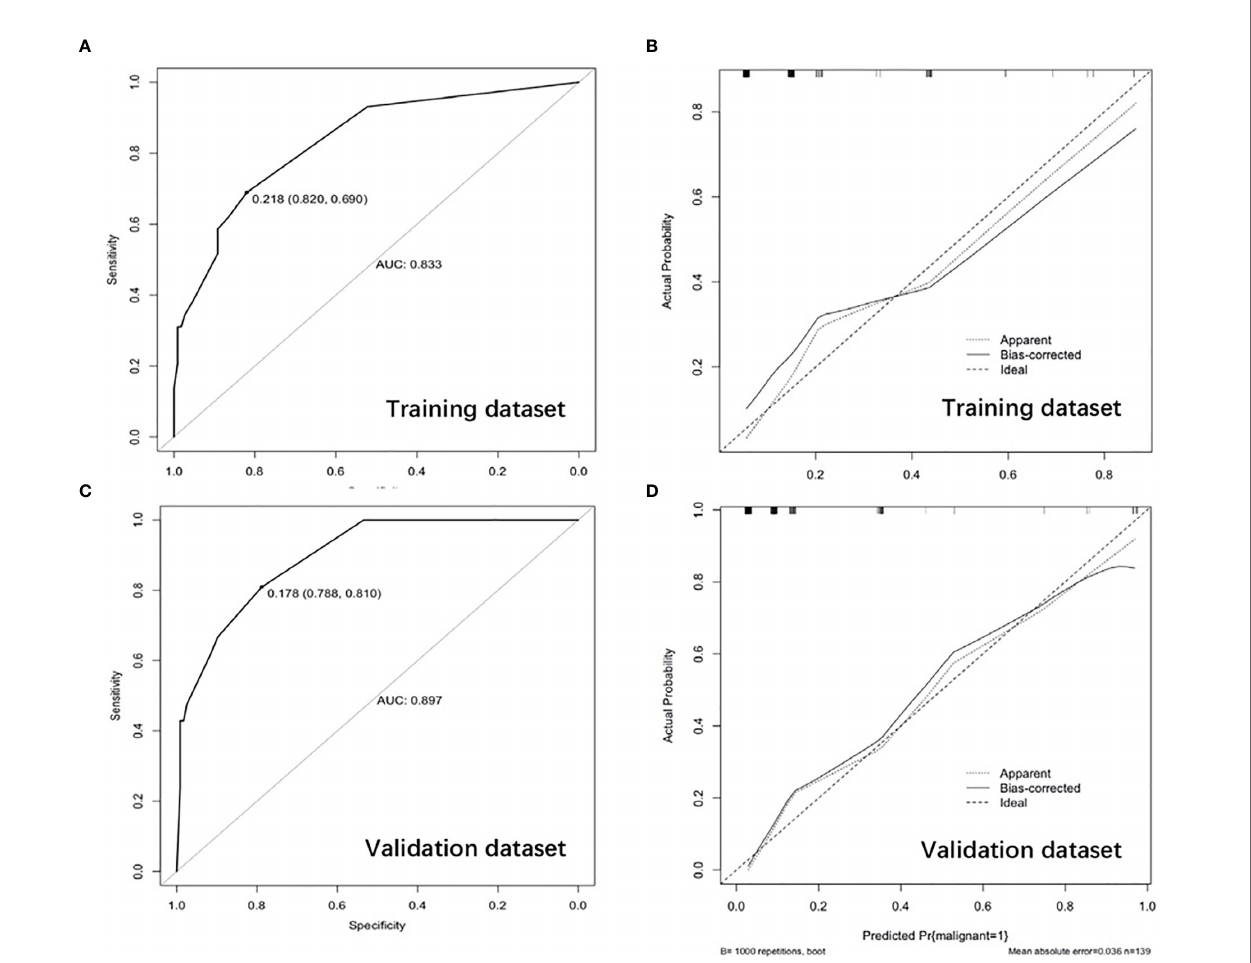
FIGURE 3 | Receiver operating characteristic curve in the training dataset (A) and validation dataset (C) . Calibration curve showing nomogram-predicted malignancy compared with the actual malignancy in the training dataset (B) and validation dataset (D) .